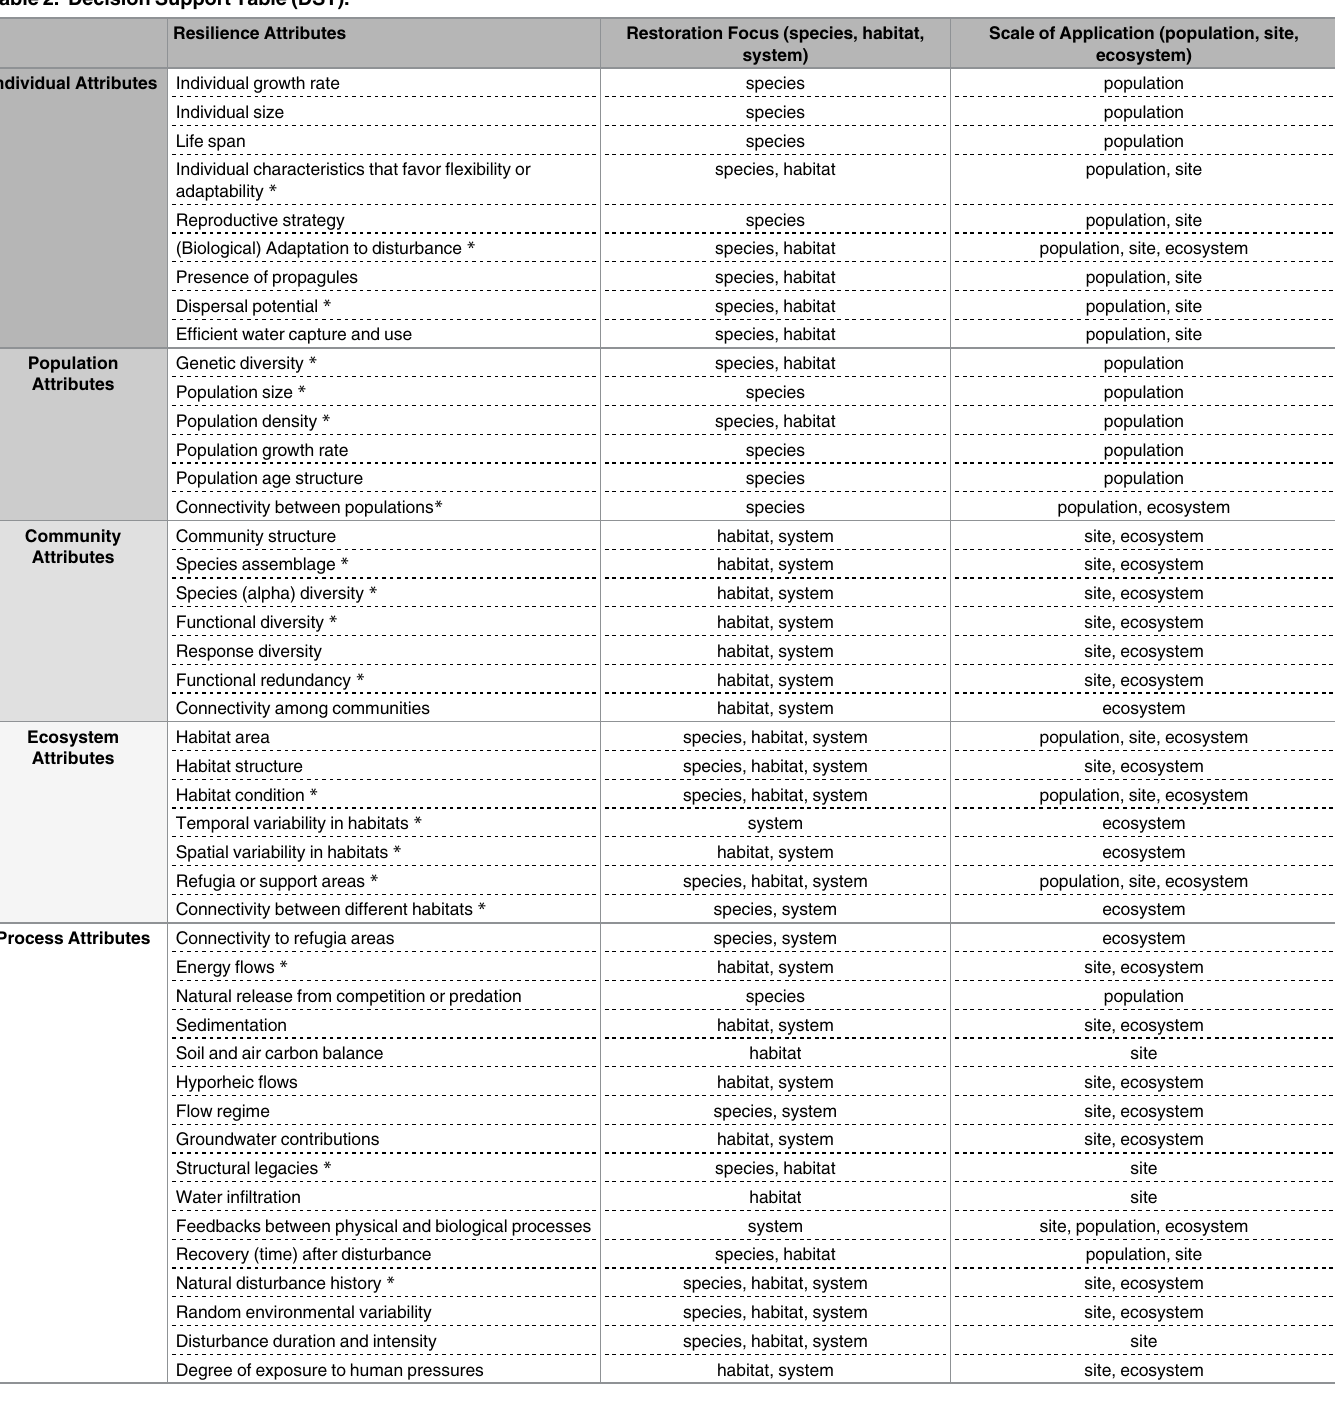
Table 2. Decision Support Table